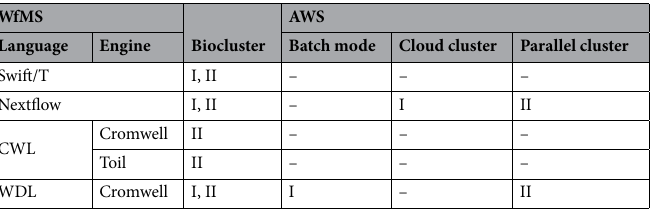
Table 5. Computational testing environments. I and II refer to: Use case I: variant calling pipeline and Use case II: scalability evaluation